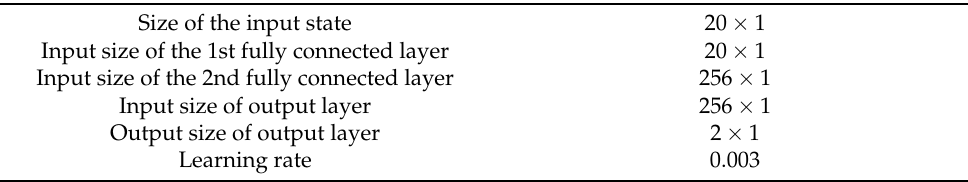
Table 3. Hyperparameter settings of the proposed actor